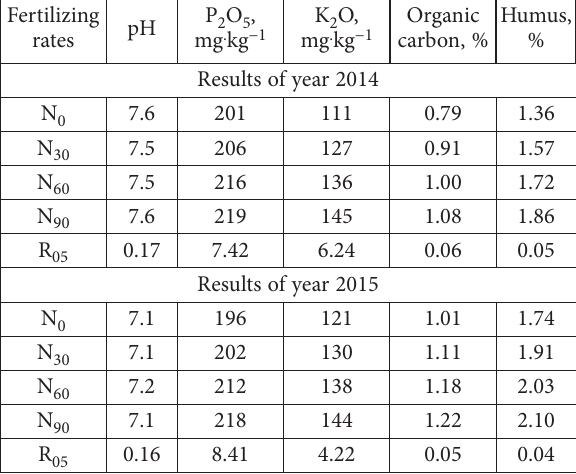
Organic Humus, carbon, % %